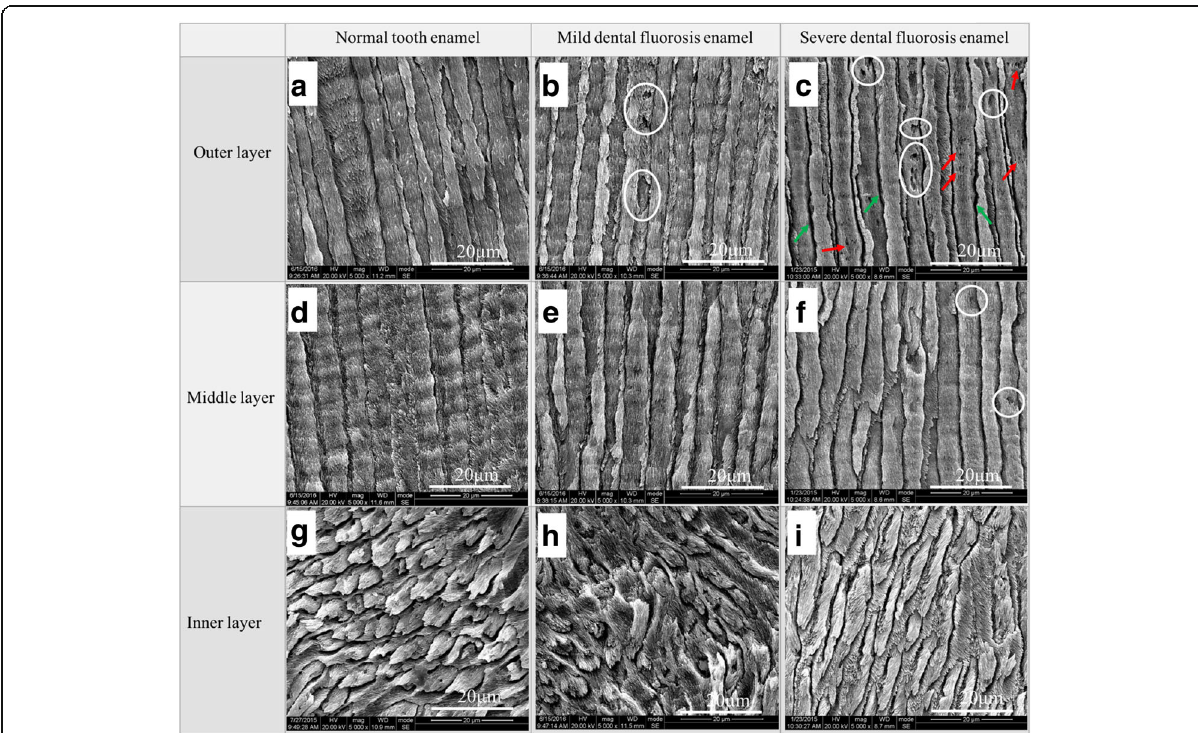
Fig. 2 SEM images of the normal tooth enamel, mild dental fluorosis enamel, and severe dental fluorosis enamel. The a – c outer layers, d – f middle layers, and g – i inner layers were etched with 37% phosphoric acid for 30 s and then visualized under ×5000 magnification. Green arrows indicate broadened gaps between the enamel rods, while white circles indicate pores. Red arrows indicate loosely arranged crystals in the enamel rods with increasing crystal clearance and